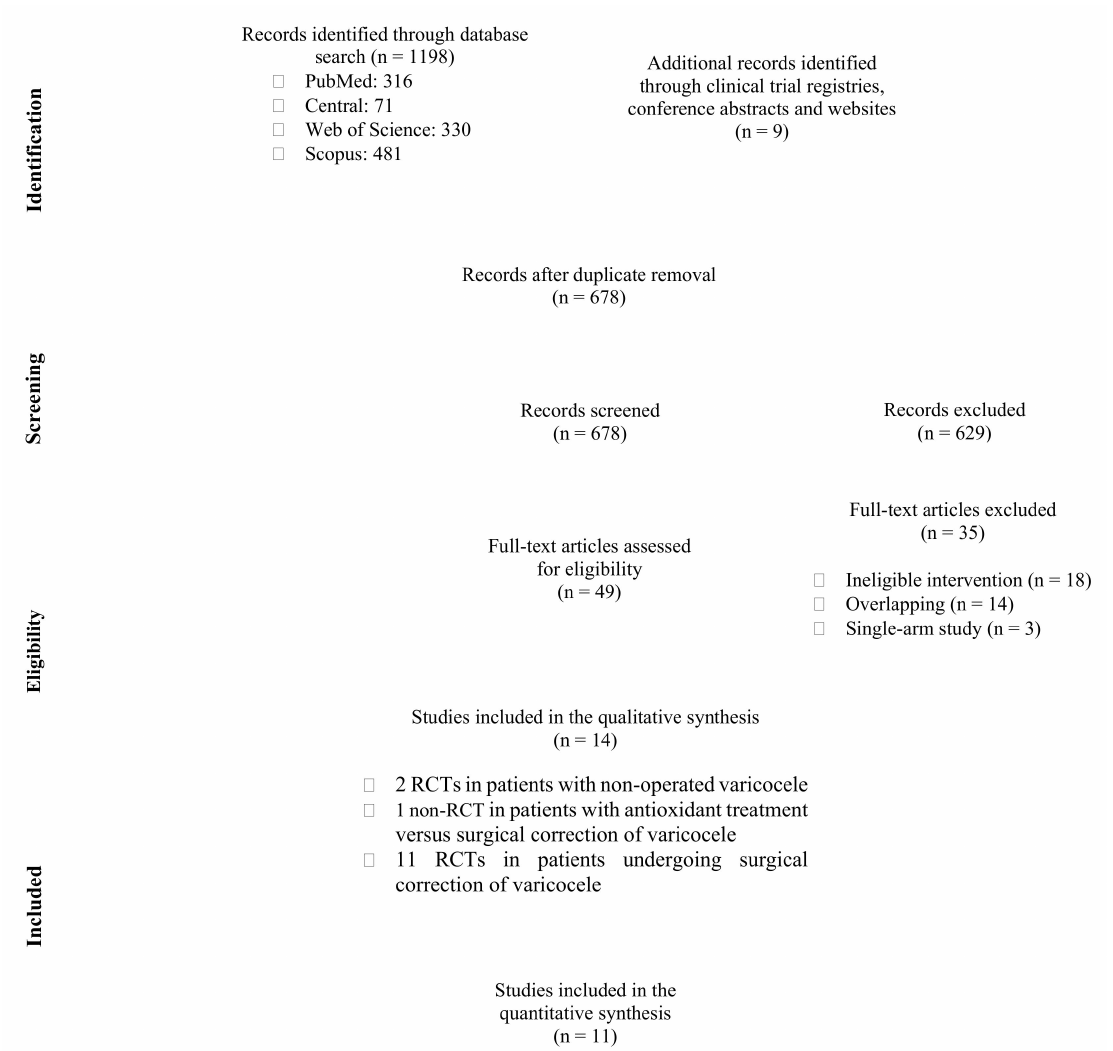
Figure 1. Flow diagram of study selection process. RCT: randomized controlled